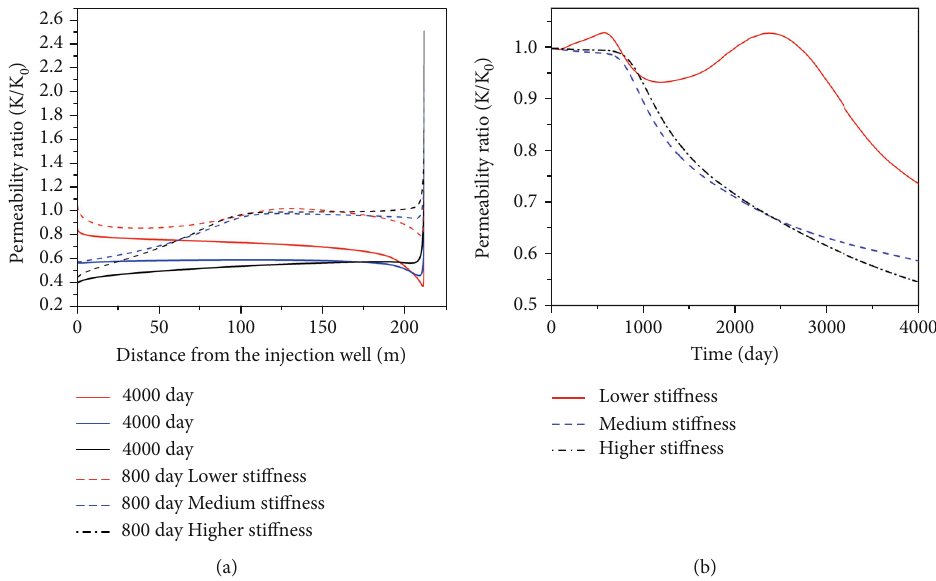
Figure 13: Permeability evolution within CBM reservoir during CO2-ECBM production project. (a) Evolution of permeability ratio along reference section A-B. (b) Evolution of permeability ratio at reference point (P2).